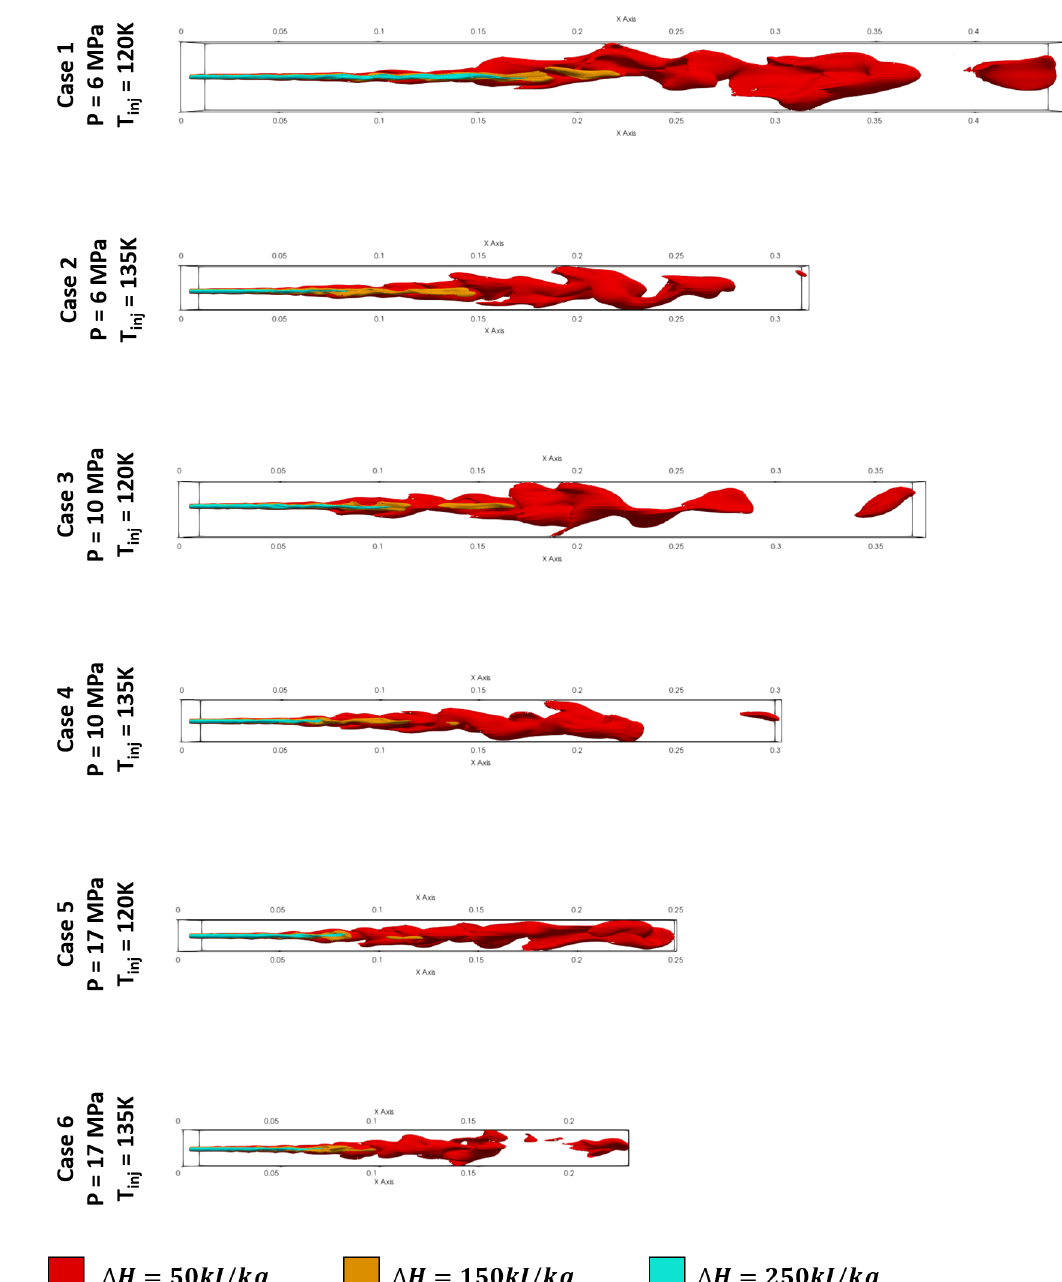
Figure 17. Isosurfaces corresponding to three different enthalpy differences, between the enthalpy of the injected nitrogen and the enthalpy of the nitrogen at chamber temperature for all the cases at t = 1 s from